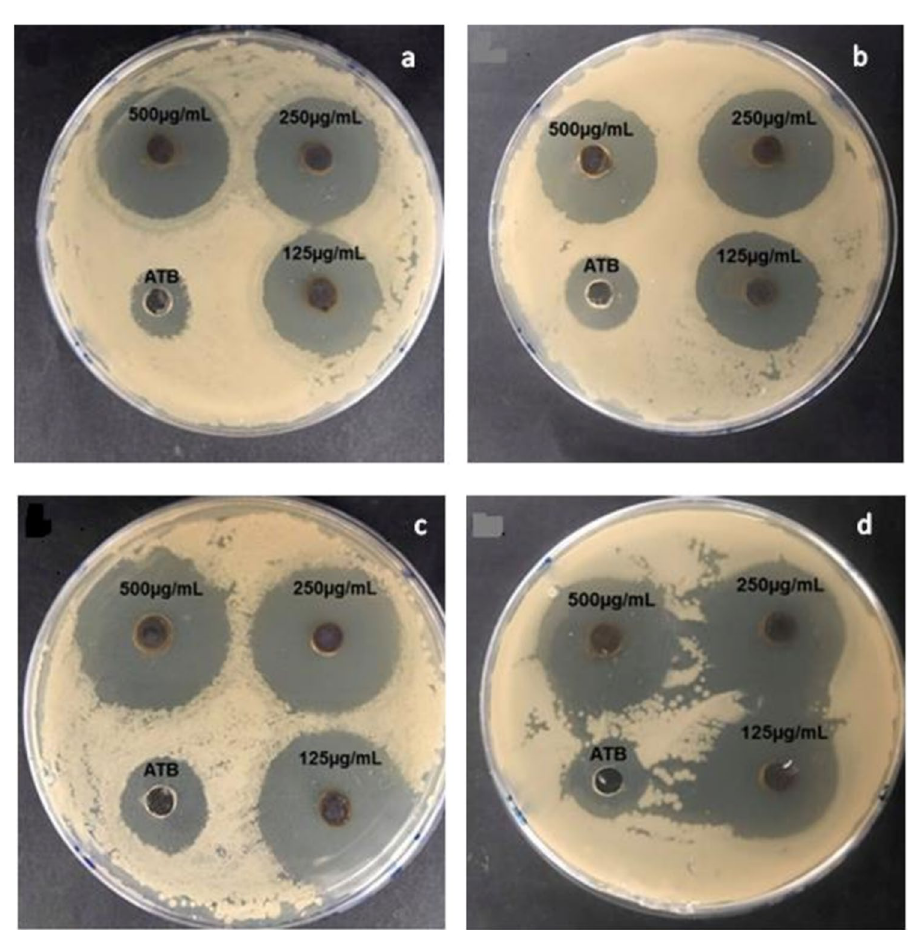
Figure 4. Antibacterial activity of biosynthesized AgNPs at different concentrations (125, 250, and 500 µg/mL) evaluated by agar well diffusion. AgNPS Control against (a) E. coli ( b) S. aureus . AgNPs SMF (c) E. coli (d) S. aureus